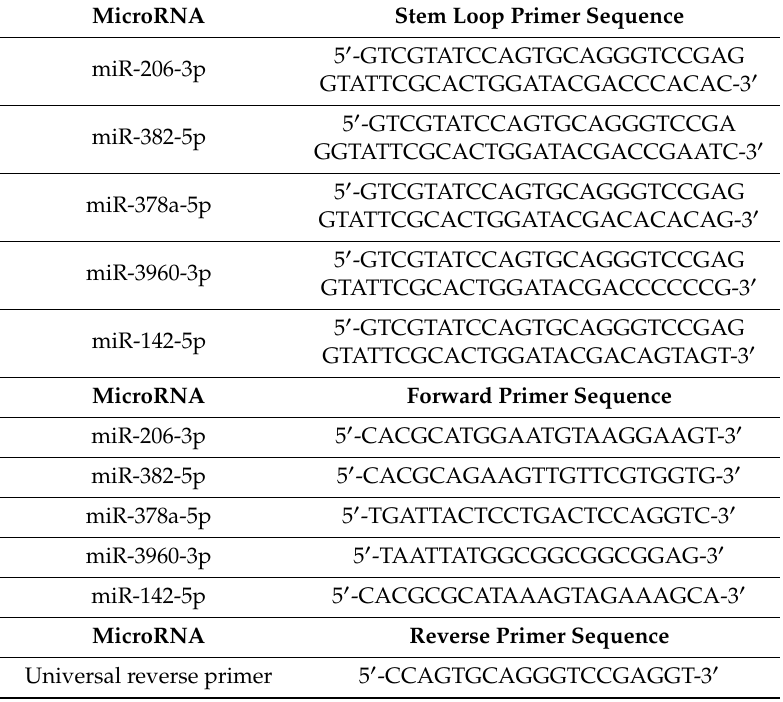
Table5. Thelistofstemloopprimers, forwardprimers,